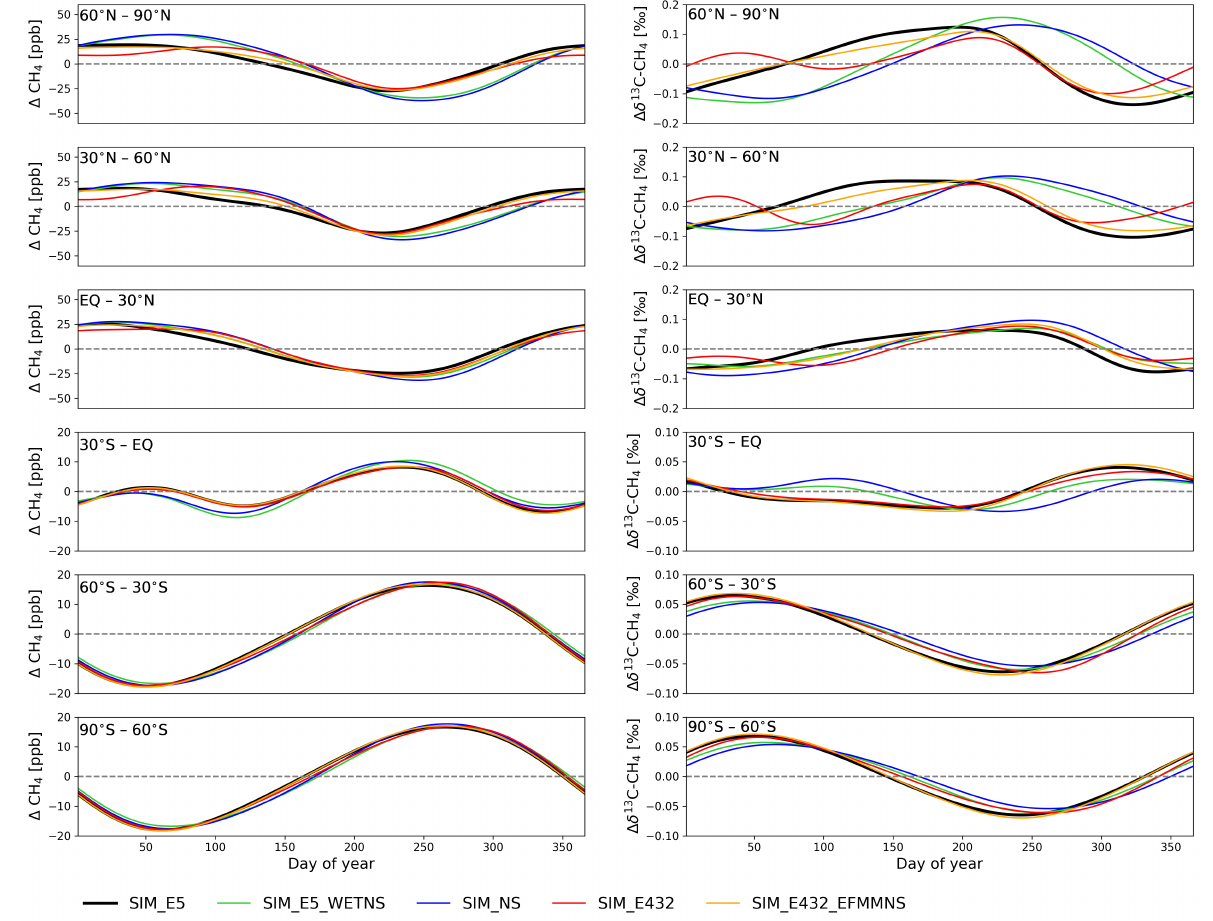
Figure 2. De-trended zonal mean averages for CH 4 ( left ) and 𝛿 13 C ( right ) from model simulations averaged over 2002–2012 and the lowest five layers. Note the differences in the y-axis for the Northern and Southern